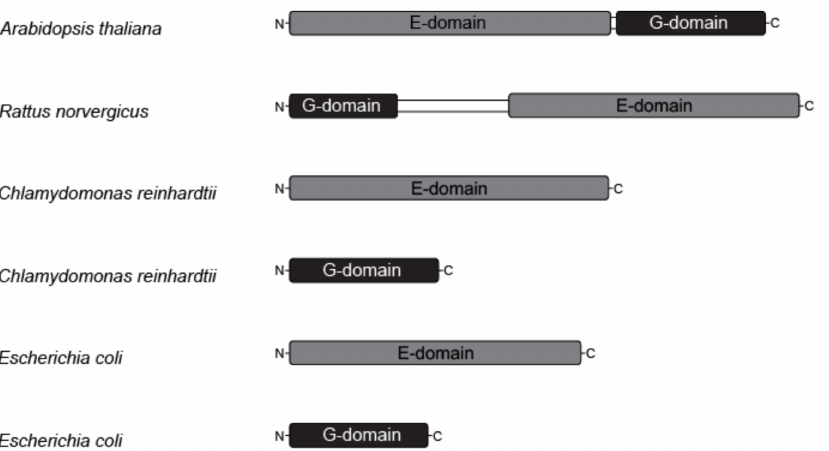
Figure 3. Domain organization of eukaryotic and prokaryotic molybdenum insertases. The domain organization of the Mo-insertases from Arabidopsis thaliana (annotation according to [37]), Rattus norvegicus (annotation according to [35]), Chlamydomonas reinhardtii (E-domain: GenBank entry DQ311646, G-domain: GenBank entry DQ311645.1C) and Escherichia coli (MoeA: NCBI Reference Sequence NP_415348.1, MogA: NCBI Reference Sequence: NP_414550.1) is shown schematized.